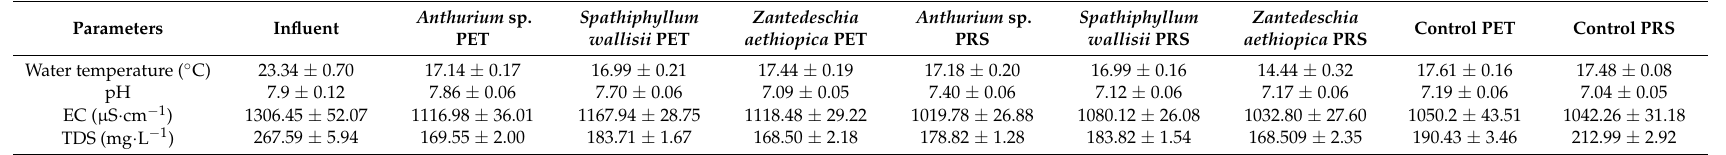
Table 1. Wetland plants in different substrates. Chemical parameters at the inlet and outlet of wetland